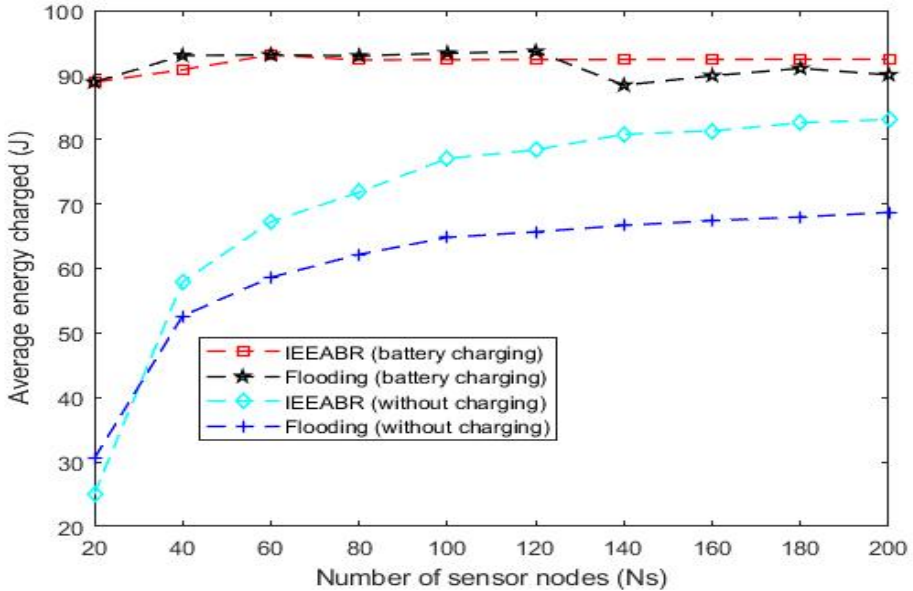
Figure 7. Effect of number of sensor-nodes on average energy charged for MCBR-Flooding and IEEABR routing protocols.